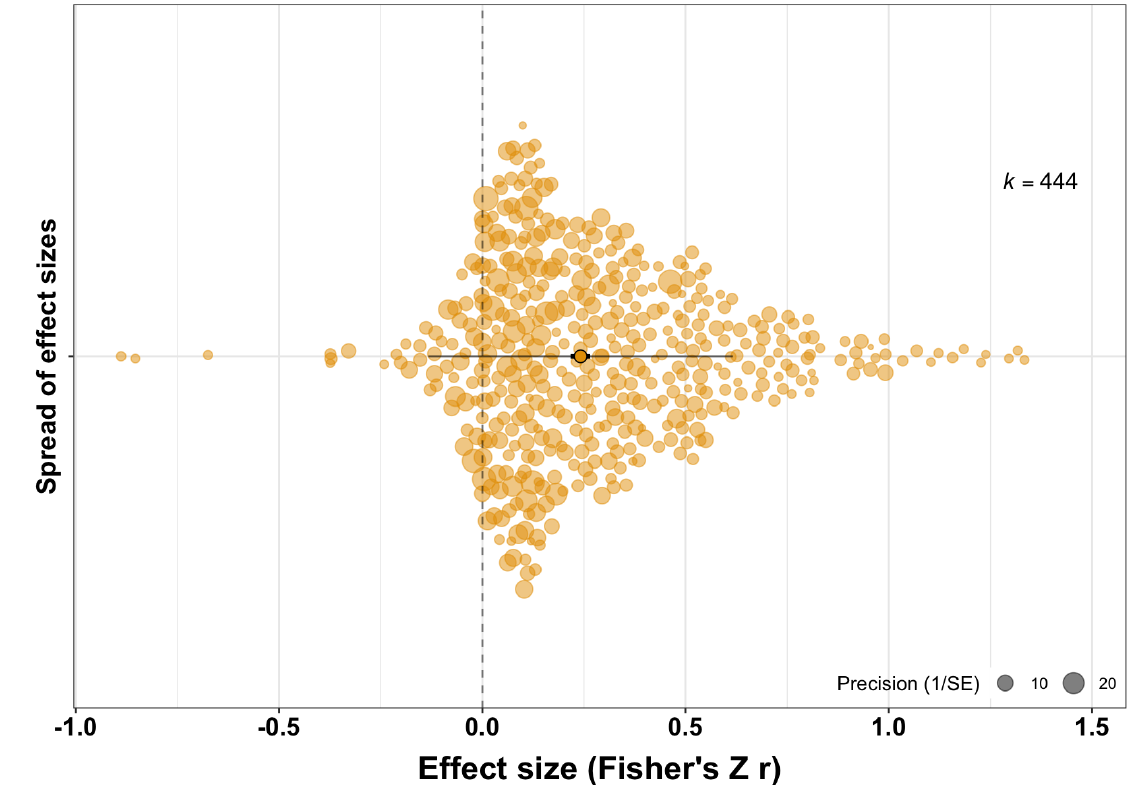
Figure 2. Orchard plot displaying the spread of the 444 effect sizes in our sample (each dot represents a single effect size, the size of the dot indicates the precision). Overall, most studies report a positive association between dominance rank and reproductive success (darker circle in the center indicates the mean, thick black edge right next to circle indicates precision interval, thin black lines extending from darker circle the confidence interval of the estimate). Our sample does show bias, with effect sizes not distributed symmetrically around the center but showing an overrepresentation of highly positive